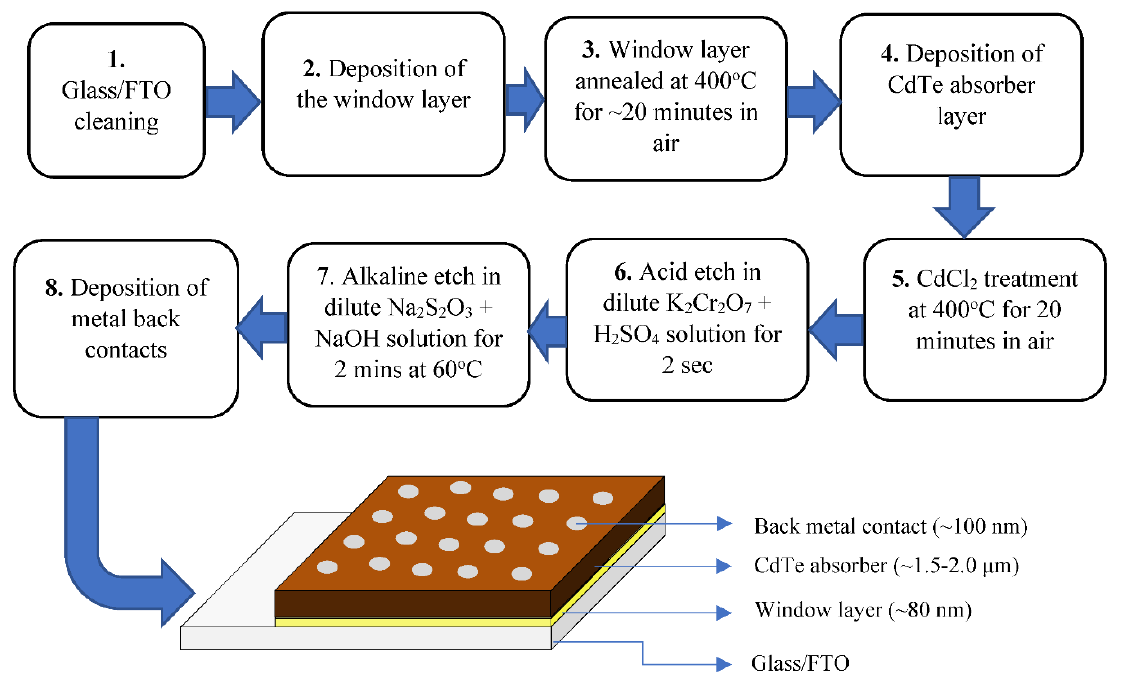
Figure 1. Basic processing steps of fabricating, and the schematic diagram of the glass/FTO/CdS/CdTe/metal PV solar cells.